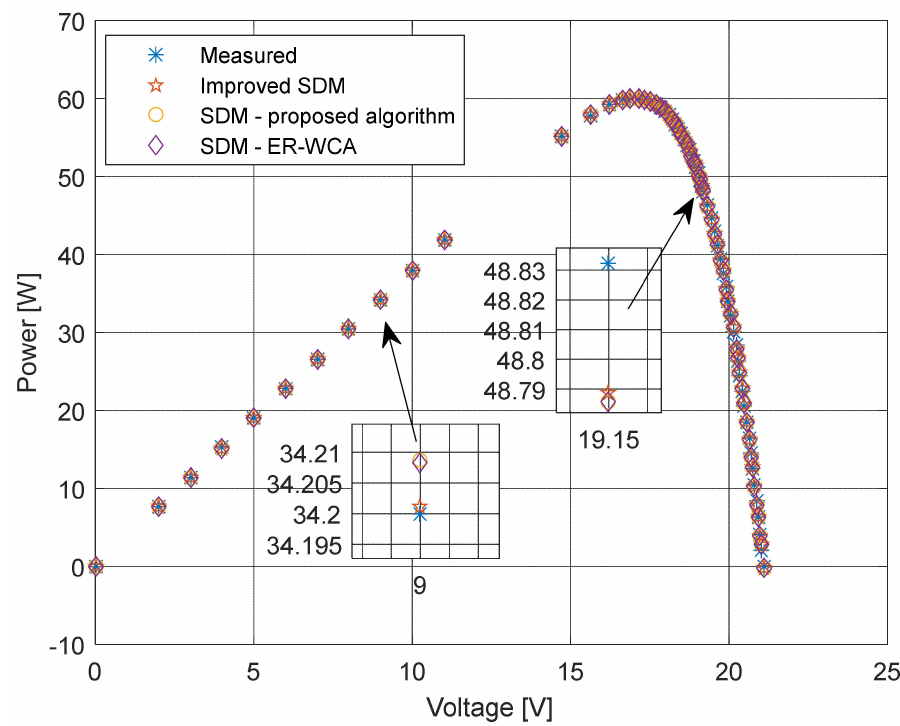
Figure 22. Power–voltage characteristics obtained using different methods for both SDM and